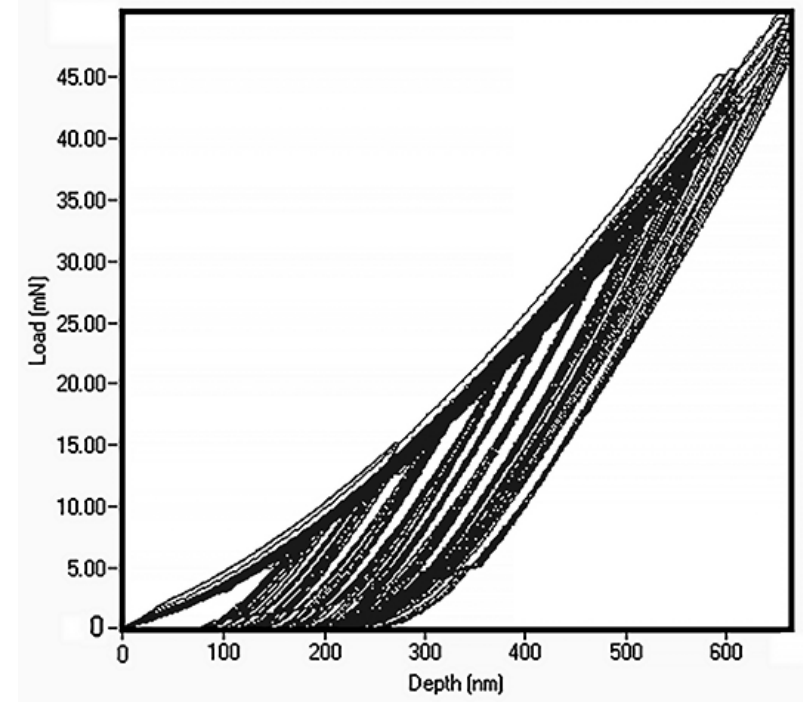
Figure 5. Nanoindentation data for FeMnNiAlC 10 amorphous HEATF. The true value of the reduced Young’s modulus should be determined at zero load as prescribed by the international standard (ISO 14577-4:2016). Linear extrapolation to zero penetration depth gives 103 ± 4.6 GPa for the thin film as evident from Figure